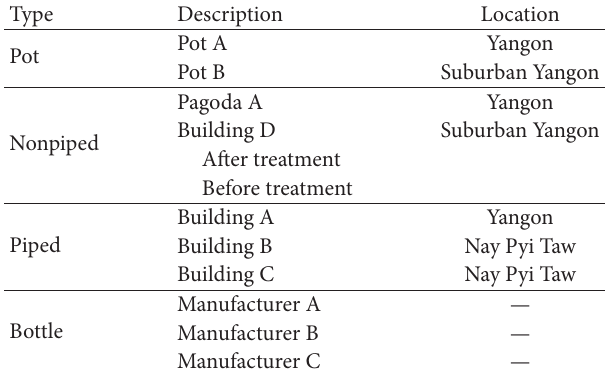
Figure 2: Roadside pots containing water for